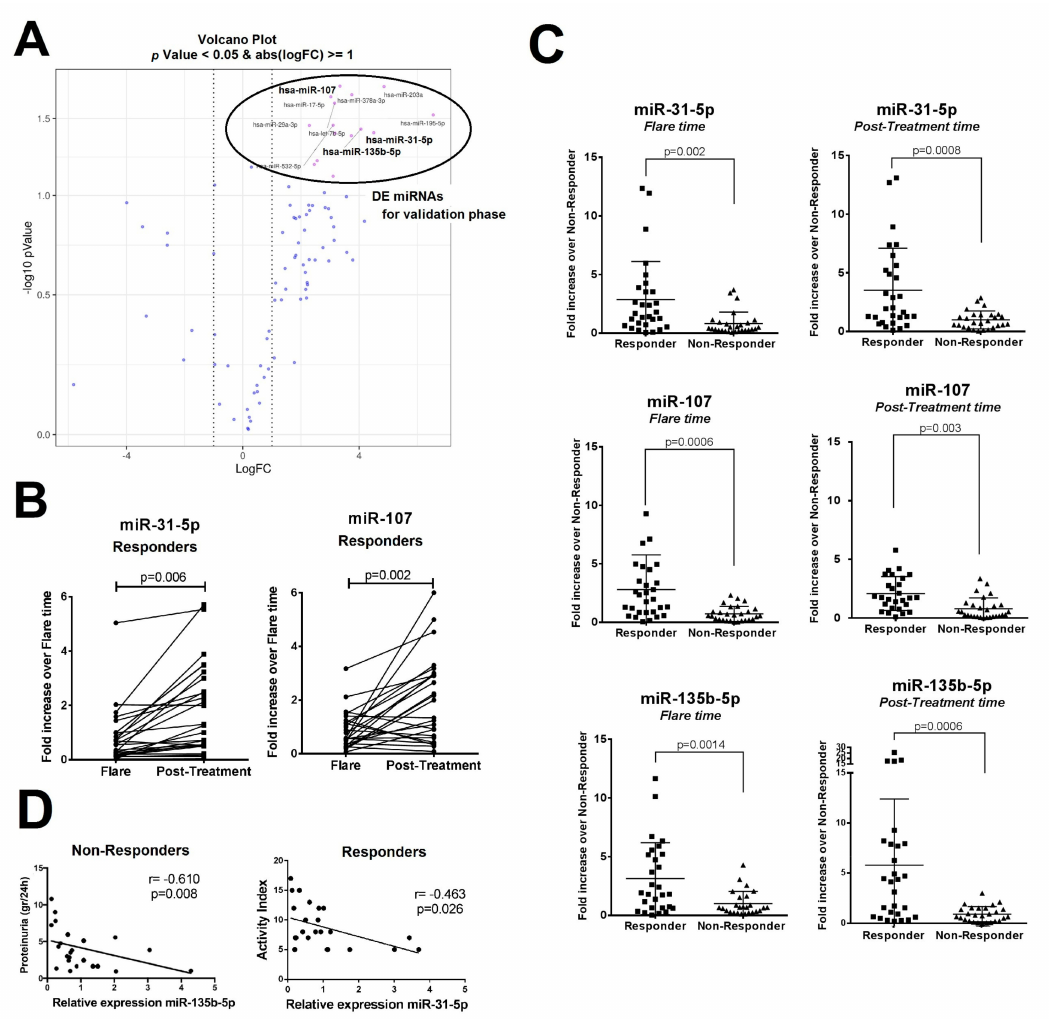
Figure 1. Urinary exosomal miRNA expression profile from lupus nephritis (LN) patients according to their clinical response. Expression of di ff erentially expressed miRNAs was evaluated using quantitative real-time PCR (qRT-PCR) in the screening cohort and in the validation cohort of lupus nephritis patients (responders ( n = 29) and non-responders ( n = 28)). ( A ) Volcano plot shows the most di ff erentially and significantly expressed miRNAs found in the screening cohort. Three of these mRNAs were validated (marked in bold). DE: di ff erentially expressed. ( B ) Paired t -test analysis was done between flare and post-treatment time points in the responder group. Significant di ff erences are shown with the corresponding p -values. ( C ) MiR-31-5p, miR-107, and miR-135b-5p expression from the LN responder and non-responder groups at flare time or post-treatment time are shown as individual plots. Gene expression was normalized using U6 as endogenous control. Fold change in expression level was calculated using the 2 − ∆∆ Ct method. p -Values were obtained using Student’s t -test. ( D ) Correlation of corresponding miRNAs expression levels with proteinuria and activity index at flare time. Spearman’s rank-order correlation was used to obtain r- and p